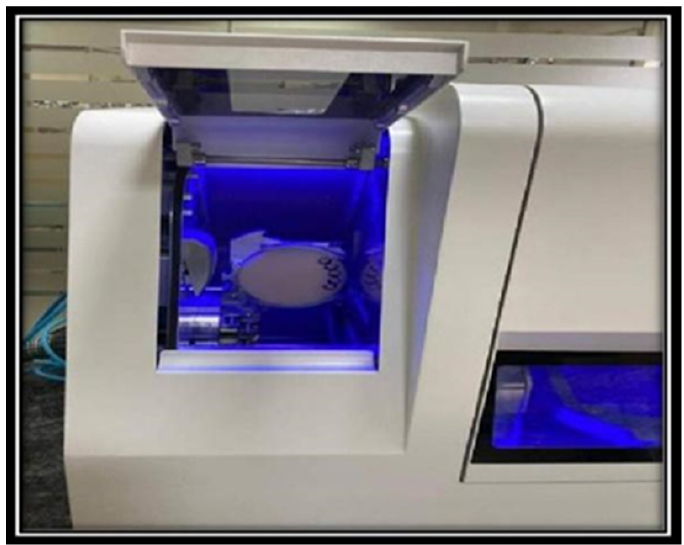
Figure 3. Milling of PMMA resin pattern.